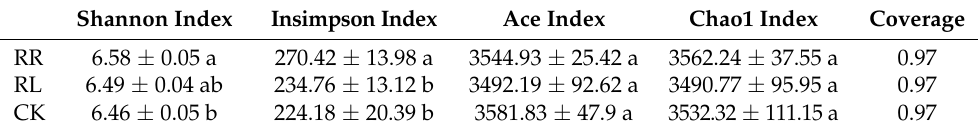
Table 3. Soil bacterial alpha diversity in rhizospheres of oilseed rape under RR, RL and CK systems. Note: Data in the table are means ± SDs. Values followed by different lowercase letters indicate significant Shannon Index differences between different rows ( p < 0.05).